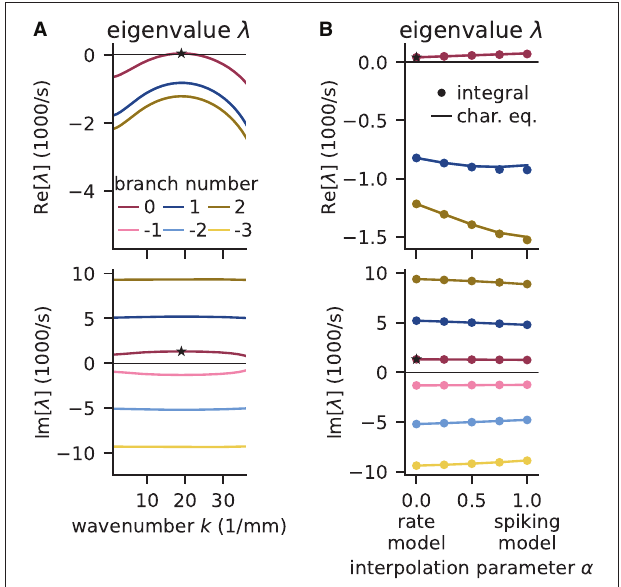
FIGURE 9 | Linear stability analysis of spatially structured network model. (A) Analytically exact solution for real (top) and imaginary (bottom) part of eigenvalue λ vs. wavenumber k using rate model derived by fit of spiking ( 10, 10 ) mV. Color-coded branches of model at working point (µ , σ) = Lambert W B function; maximum real eigenvalue (star marker) on principal branch ( B 0). (B) Linear interpolation between rate ( α 0) and spiking = = model ( α 1) by numerical integration of Senk et al. (2020, Equation 30) (solid = line) and by numerically solving the characteristic equation in Senk et al. (2020, Equation 29) (circular markers). Star markers at same data points as in (A) . Similar displays as in Senk et al. (2020, Figure